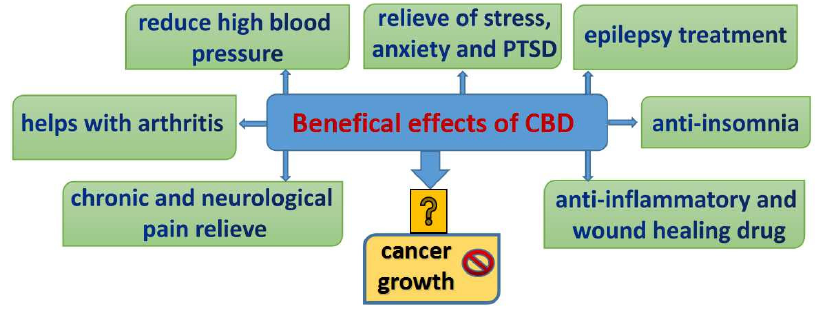
Figure 1. Major beneficial effects of CBD usage [37 – 40].